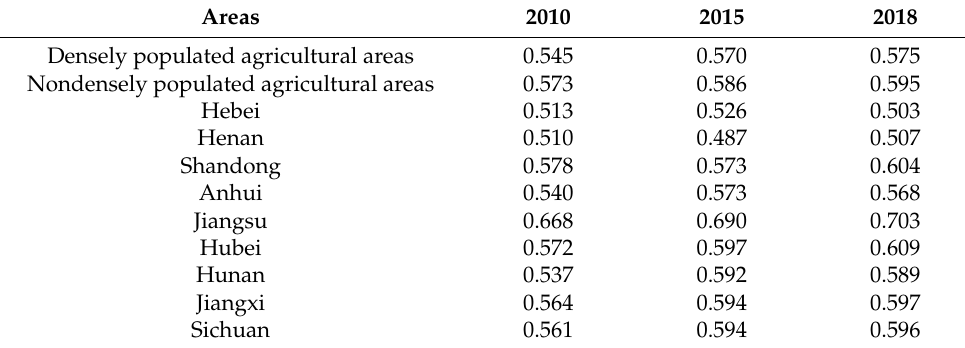
Table 4. Average comprehensive urbanization quality in 2010, 2015, and